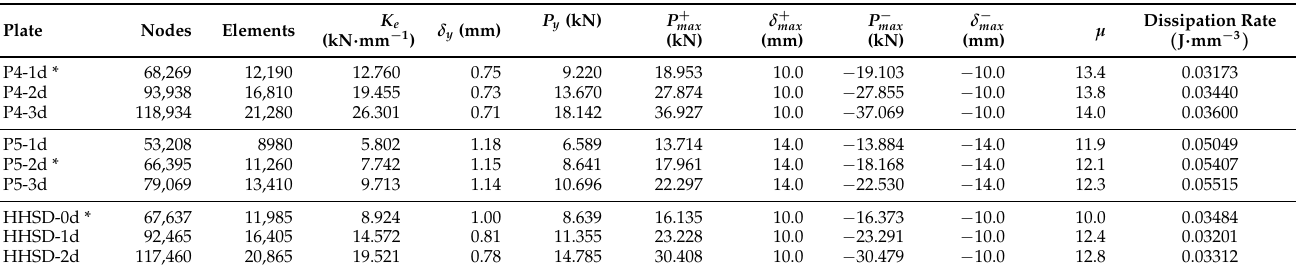
Table 5. Summary of numerical performance results as a function of parametric variation of number of diagonals in the